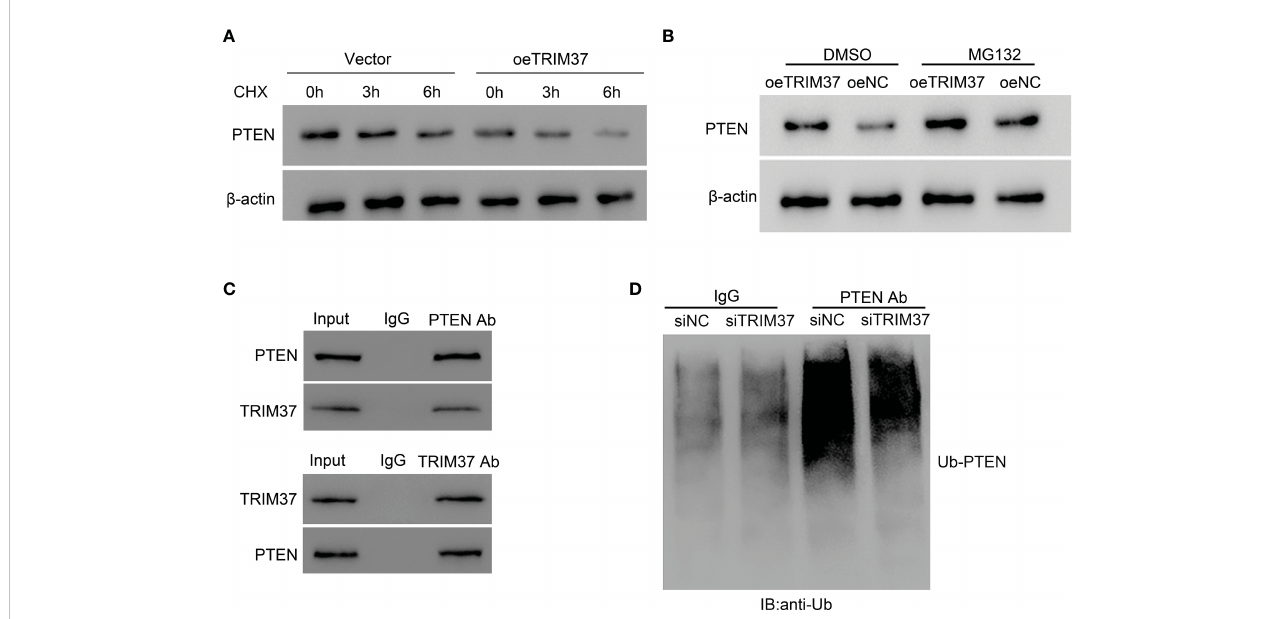
FIGURE 4 TRIM37 mediated the ubiquitination of PTEN in human MOLT-4 cells. (A) PTEN protein level was measured under 10 m M of CHX. (B) The effect of proteasome on PTEN expression was examined by Western blot assays. (C) Co-immunoprecipitation (Co-IP) experiments to investigate the interaction between TRIM37 and PTEN. Immunoprecipitation (Co-IP) experiments to detect the ubiquitination of PTEN. (D) Ubiquitination assay was used to examine the ubiquitination of PTEN in siNC and siTRIM37 transfecting cells.